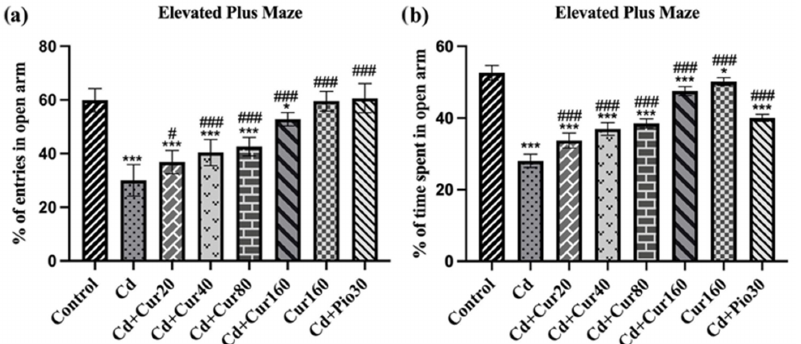
Figure 4. Effect of curcumin on Cd exposed mice showing anxiety-like behavior; ( a ) % of entry in open arm and ( b ) % of the time in open arm. Each column represents the mean ± SEM of 7 animals. One-way ANOVA followed by Dunnett’s post-test; * p < 0.05 and *** p < 0.001 showing significant differences between control and treatment group. # p < 0.05 and ### p < 0.001 and showing significant differences between Cd exposed group and curcumin treated groups.